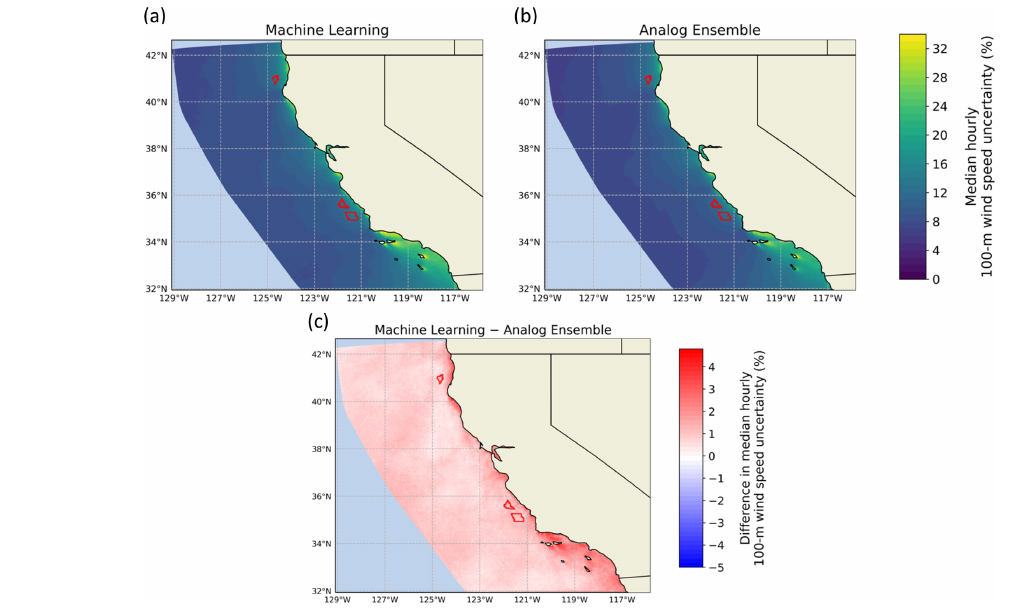
Figure 5. Median hourly boundary condition and parametric uncertainty for the 100m wind speed, as derived from the machine-learning approach (a) , the analog ensemble (b) , and the difference between the two (c) .